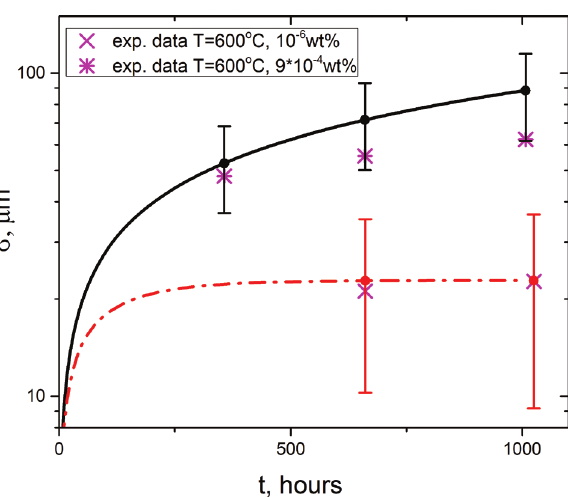
Figure 9. Calculated results and experimental data based on static and dynamic experiments for T91 steel (Balbaud-Celerier et al. 2004). The calculated error is 55% for a dynamic experi - ment and 30% for a